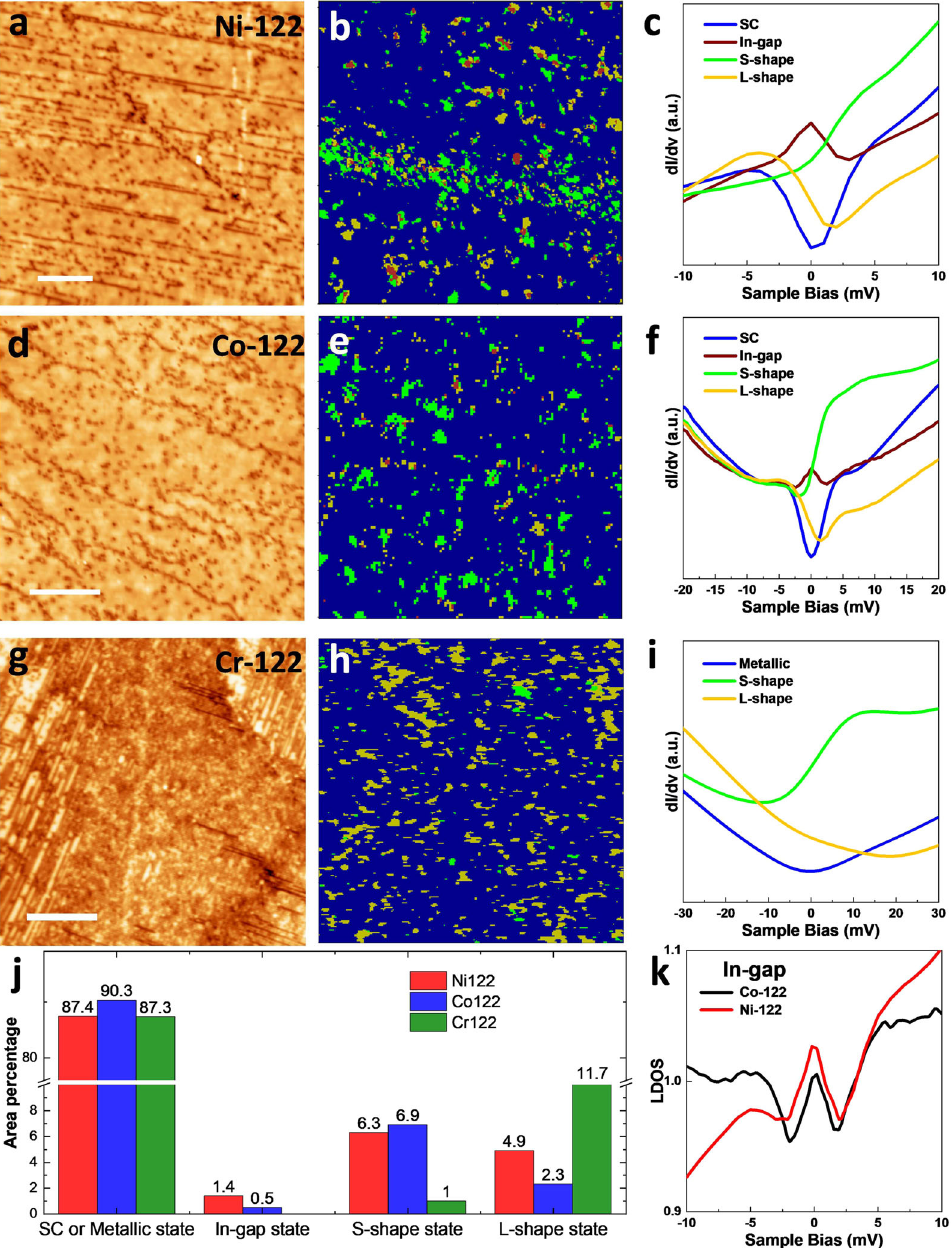
Fig. 3 K-means clustering comparison of Ni-122, Co-122, and Cr-122. STM topographies of Ni-122 ( a ), Co-122 ( d ), and Cr-122 ( g ). b , e , h Cluster maps constructed from CITS simultaneously collected with ( a ), ( d ) and ( g ). c , f , i K-means principal responses of ( b ), ( e ) and ( h ). j The area percentages of the principal responses in Ni-122, Co-122, and Cr-122 from the three images in ( a ), ( d ) and ( g ). k LDOS comparison of the in-gap states of Ni-122 and Co-122. Ni-122, 130 nm × 130 nm, 256 × 256 pixels; Co-122, 104 nm × 104 nm, 128 × 128 pixels; Cr-122, 104 nm × 104 nm, 256 × 256 pixels, the scale bars represent 25 Cr-122 from the three sets cluster maps in Fig. 3. The total volume Ni, Co-122 vs. Cr-122 varies slightly, the characteristic features are of the majority domains (SC or metallic) is similar for the three the same. For the S-shape, there is a highly elevated DOS at Fermi sets, but the volumes of the S-shape and L-shape states show a level, and a local minimum at fi lled state, while for the L-shape noticeable difference between the SC (Ni-122 and Co-122) and there is a much lower DOS at the Fermi level, and a local minimum metallic (Cr-122) compounds. In Cr-122, the percentage of the at empty state. We speculate that the differences in the energy L-shape state is 2.4 times higher than in Ni-122(Co-122), while the scales might be the result of the in fl uence of the superconducting S-shape state is rarely found. Although the relative percentage of matrix in Ni-122 and Co-122 which is notably absent in Cr-122. S- or L- shape states are different, the total volume of the two Although the S-shape, L-shape, and in-gap states are immersed in states is quite similar in the three compounds, despite the notable the SC (or metallic for Cr-122) matrix, the spatial distribution of differences that Cr-122 is non-SC, Ni-122 is an underdoped SC and those states is not correlated. Figure 3j shows the area Co-122 is an optimally doped SC, coincident with the same percentages of each principal response in Ni-122, Co-122, and